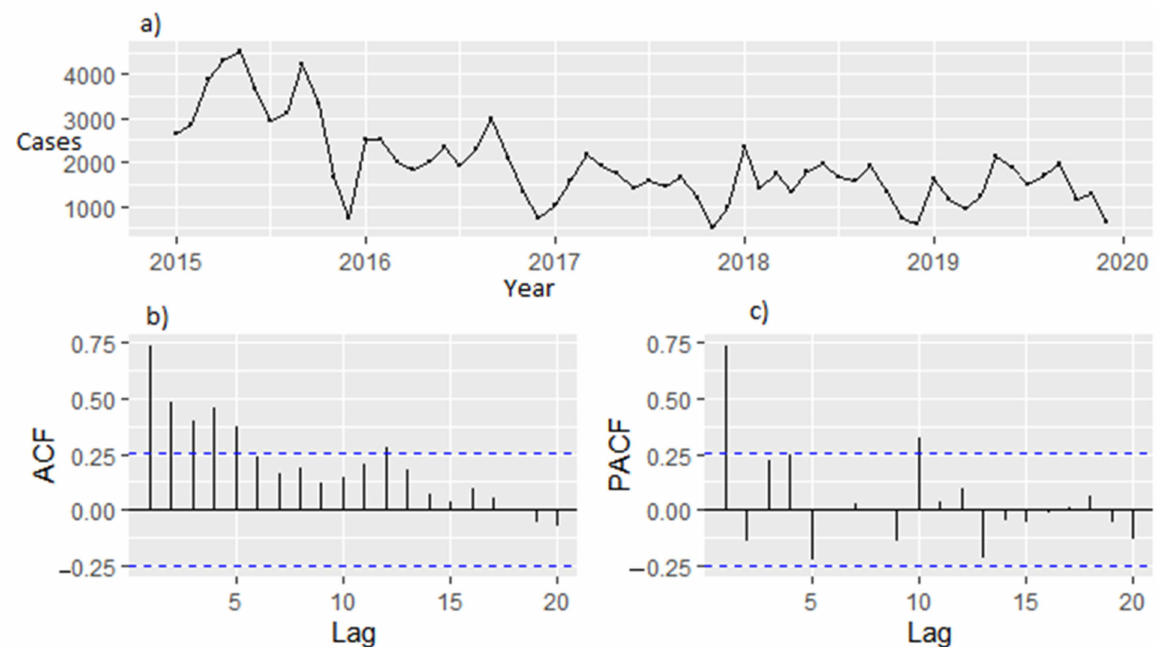
Figure 6. ( a ) Time diagram for ACF and PACF for estimating parameter before differencing: ( b ) ACF graph before differencing (d = 0, D = 0), ( c ) PACF graph before differencing (d = 0, D =